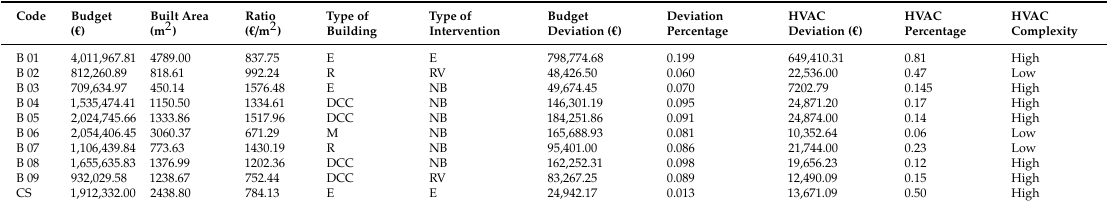
Table 2. Comparative data analysis of nine projects of di ff erent public administrations and the case study. Data derived from the case